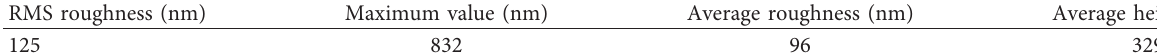
Figure 7: MOS structure of the V